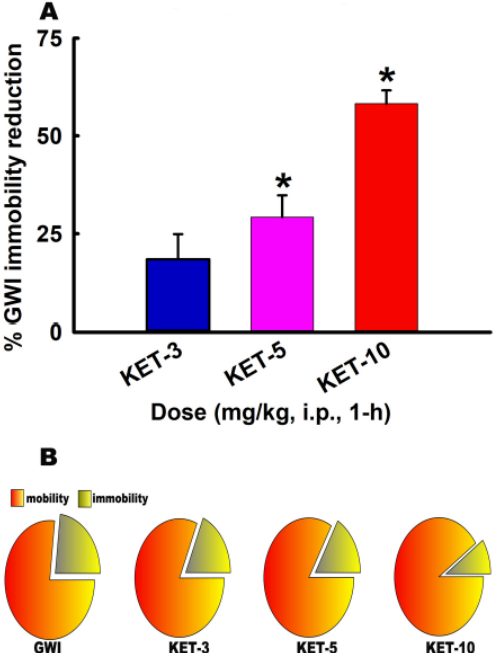
Figure 4. Rapid effect of KET on the forced swim test (FST) immobility in a DFP rat model for Gulf War Illness (GWI) ( A ) KET (5 and 10 mg/kg, i.p.) but not 3 mg/kg produced significant reductions in immobility times compared to GWI rats when tested at 1 h post-injection (data expressed as mean ± SEM of percent reduction in GWI immobility, * p < 0.05, One-way ANOVA, Tukey test, n = 7 rats/group). ( B ) Pie-chart depicting relative mobility vs. immobility percentages (exploded slice) for GWI rats treated with saline or various doses of KET.